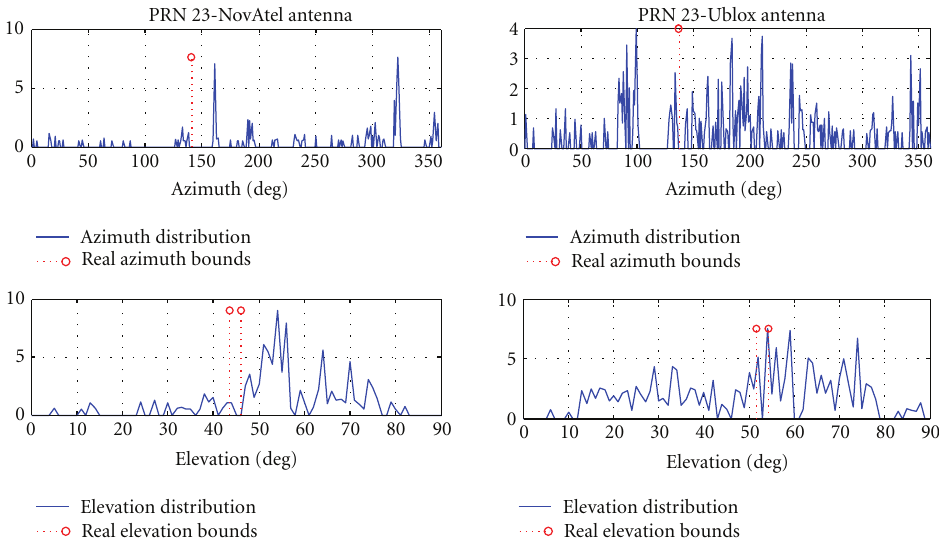
Figure 9: Measured AS profile along azimuth and elevation angles considering di ff erent antennas in the